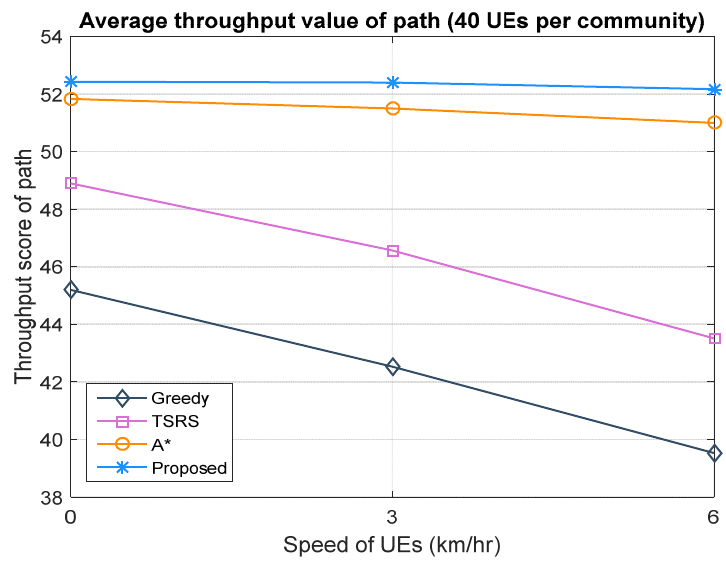
Figure 17. Delay’s utility value vs. UE’s moving speed.